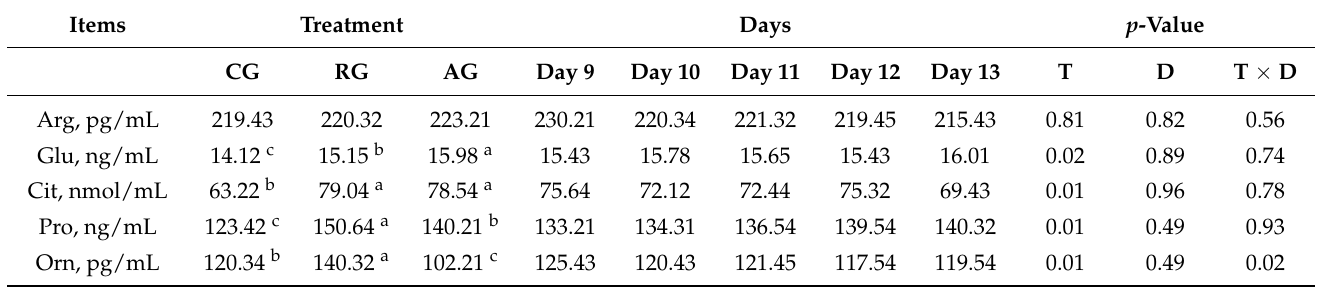
Table 4. Effects of diet and arginine on amino acid metabolism in serum of ewes 1 .